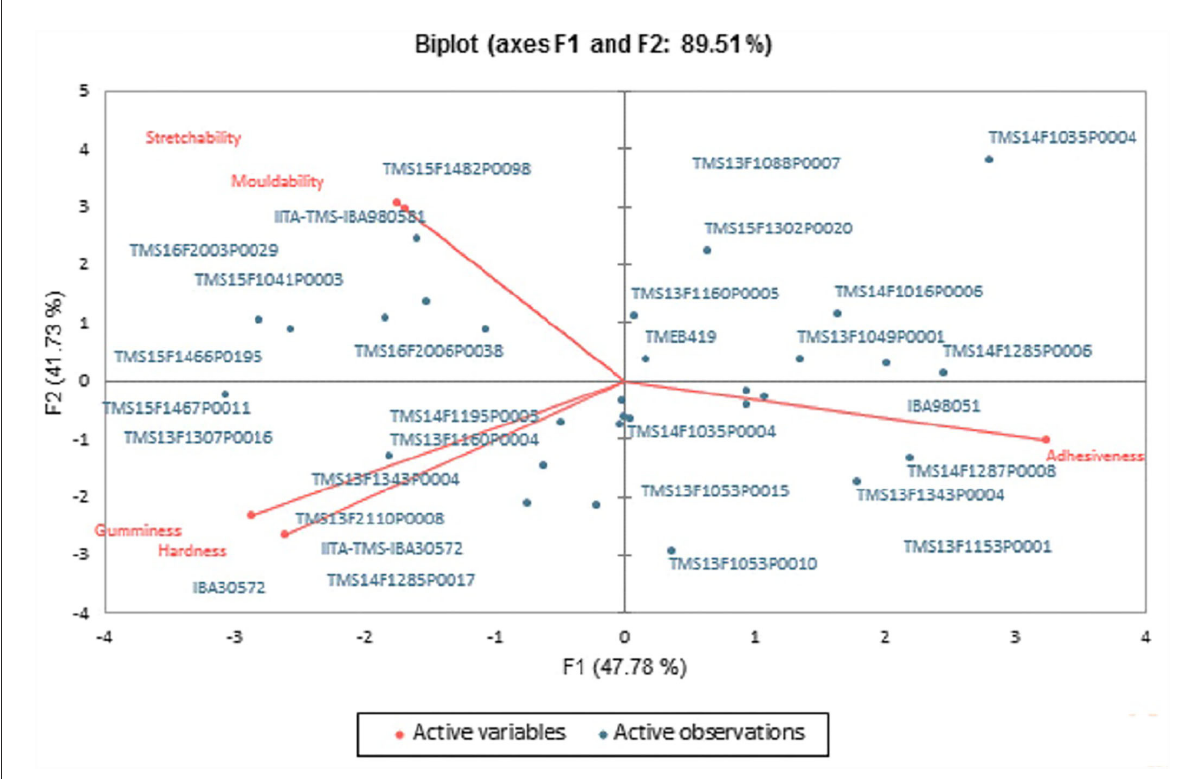
FIGURE4 The principal component analysis biplot of the instrumental texture attributes of eba from different gari